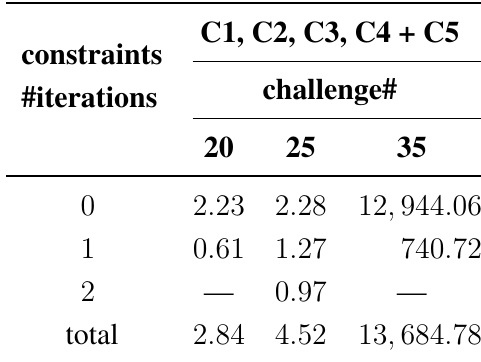
Table 2. Computational time (s) of solving IP formulations using C1–C4 with adding C5 for challenge numbers 20, 25 and